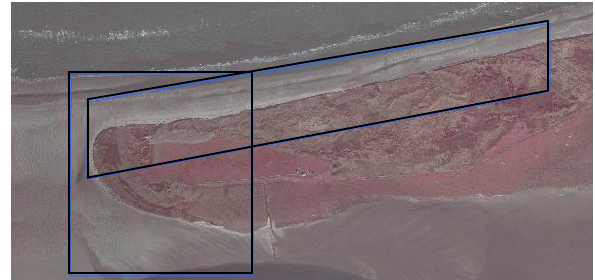
Figure 1. Orthoimage of the island Juist and the test sites in the north and the west of the island which are outlined.